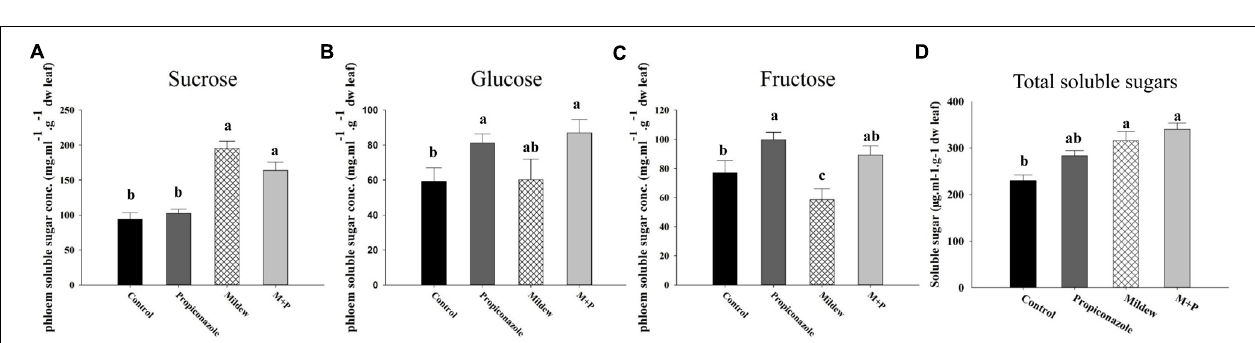
FIGURE 3 | Concentrations of individual amino acid and total free amino acids, the proportion of essential amino acids, and amino acid composition profiles in the four plant phloem. (A) Concentrations of individual free amino acid ( µ M). (B) Amino acid composition profiles (PCA). (C) The concentration of total free amino acids ( µ M). (D) The proportion of essential amino acids (mol %). Asterisk or different letters above the error bars indicate significant differences among different treatments and the error bars is ± SE bars (five biological replicates, P < 0.05, Tukey’s HSD test).